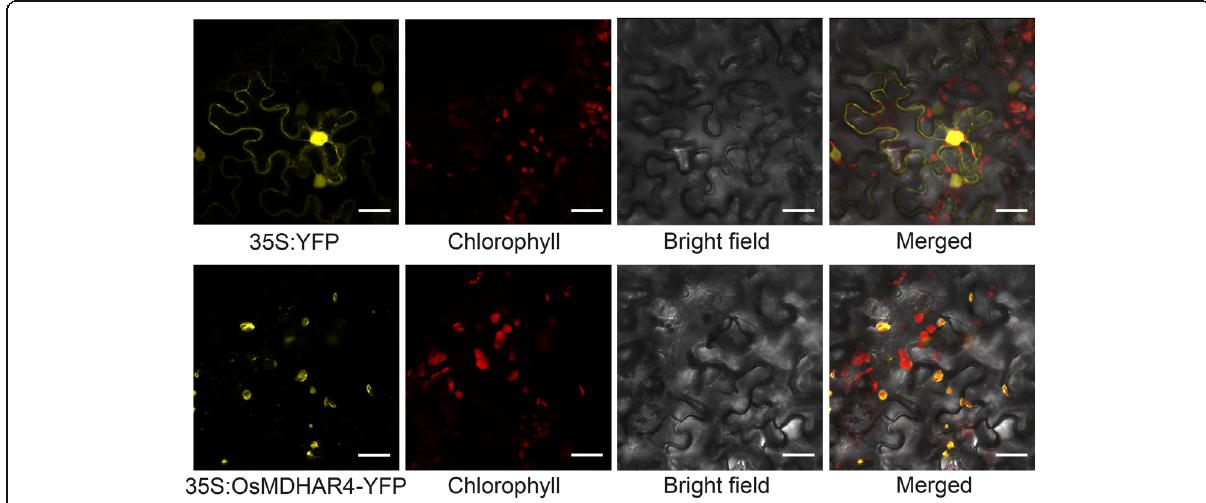
Fig. 1 Subcellular localization of OsMDHAR4 in Nicotiana benthamiana by confocal fluorescent microscopy. Red color represents the autofluorescence of chlorophyll; yellow fluorescence shows the localization of OsMDHAR4-YFP. Scale bars = 20 μ